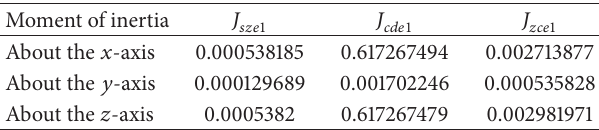
Table 3: Values of 𝐽 𝑠𝑧𝑒1 , 𝐽 𝑐𝑑𝑒1 , and 𝐽 𝑧𝑐𝑒1 .